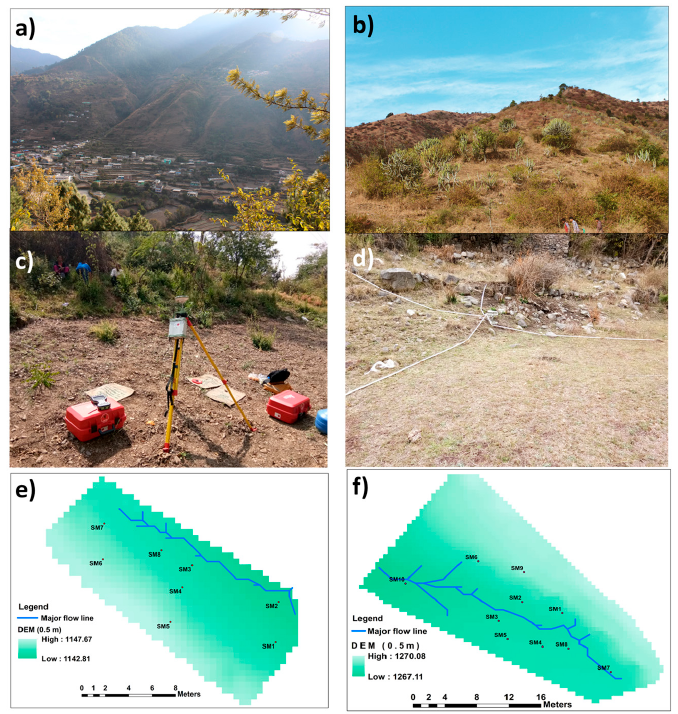
Figure 2. ( a ) North aspect of watershed dominated with agricultural lands and forests; ( b ) south aspect of watershed dominated with bushes of Cactaceae family; ( c ) agro-forested hillslope during real-time kinematic (RTK) GPS survey; ( d ) grassed hillslope during soil moisture sensors installation; ( e ) 0.5 m resolution DEM of AgF hillslope showing major flow lines and locations of soil moisture; ( f ) 0.5 m resolution DEM of GA hillslope showing major flow lines and locations of soil moisture installation point (reproduced from Figure 1 of Nanda et al. [29] with the copyright permission from Elsevier o ffi